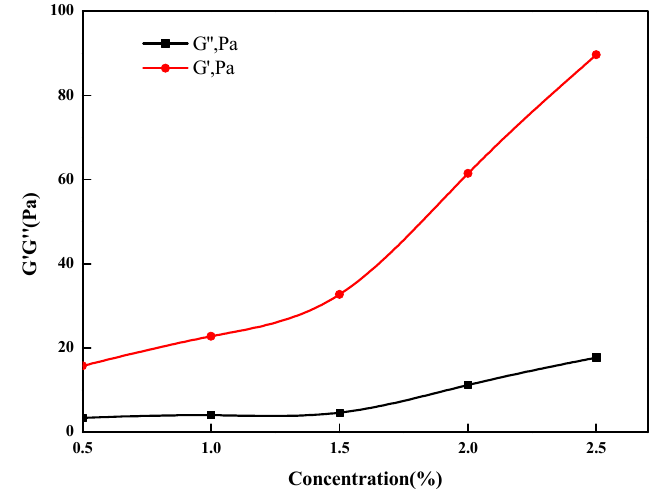
Figure 9. Viscoelasticities at different thickener concentrations.